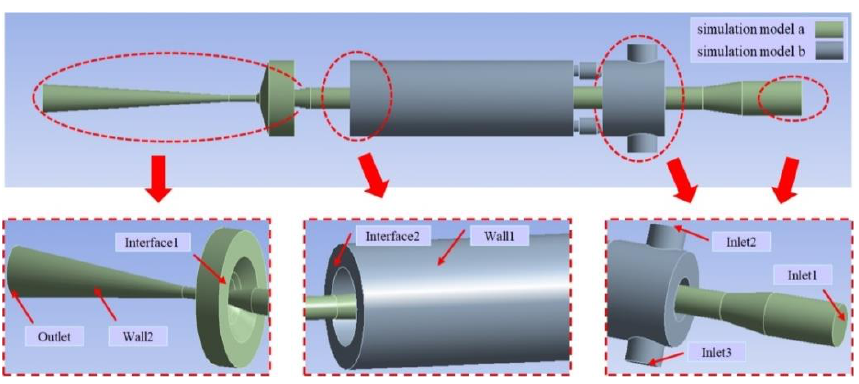
Figure 5. Simulation model of the new jet pump.